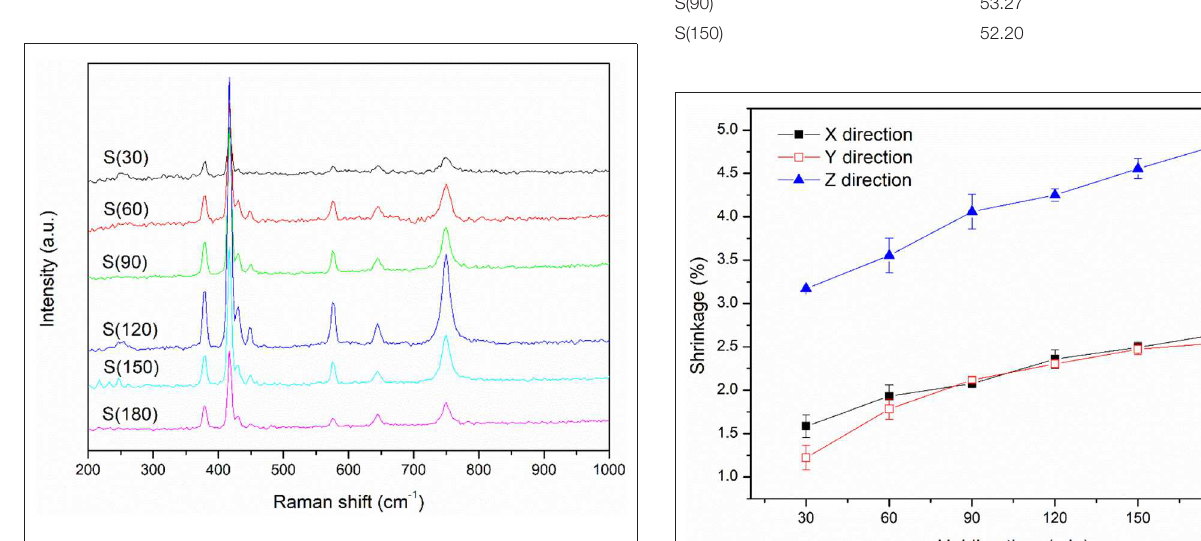
FIGURE 9 | Raman spectra of alumina ceramic sintered with different holding times.